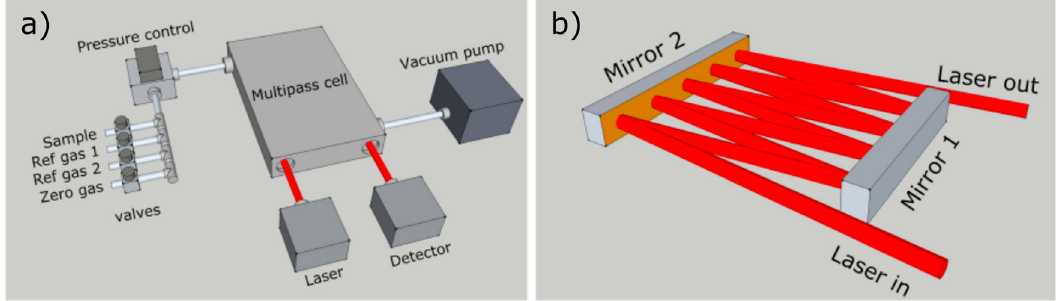
Figure 2. Schematic of the CH 4 isotope analyser and gas handling ( a ); and the optical multipass cell ( b